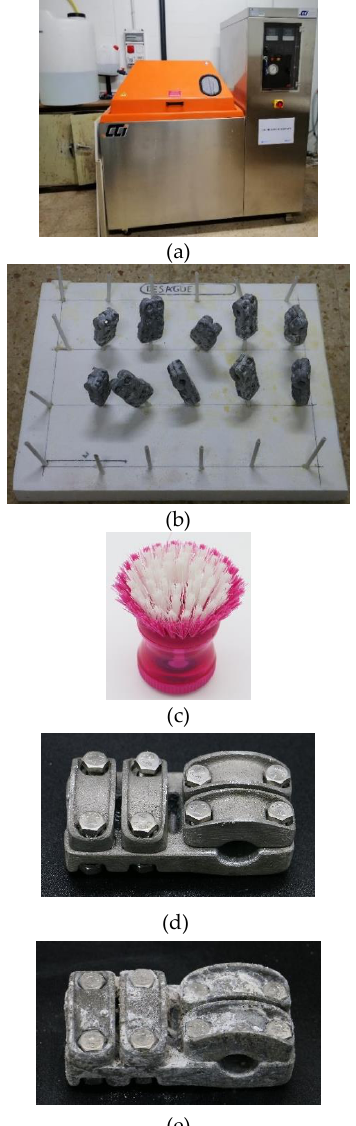
Figure 2. ( a ) Salt spray chamber. ( b ) Layout of the test specimens to be placed inside the salt spray chamber. ( c ) Brush used to clean the connectors once removed from the salt spray chamber. ( d )